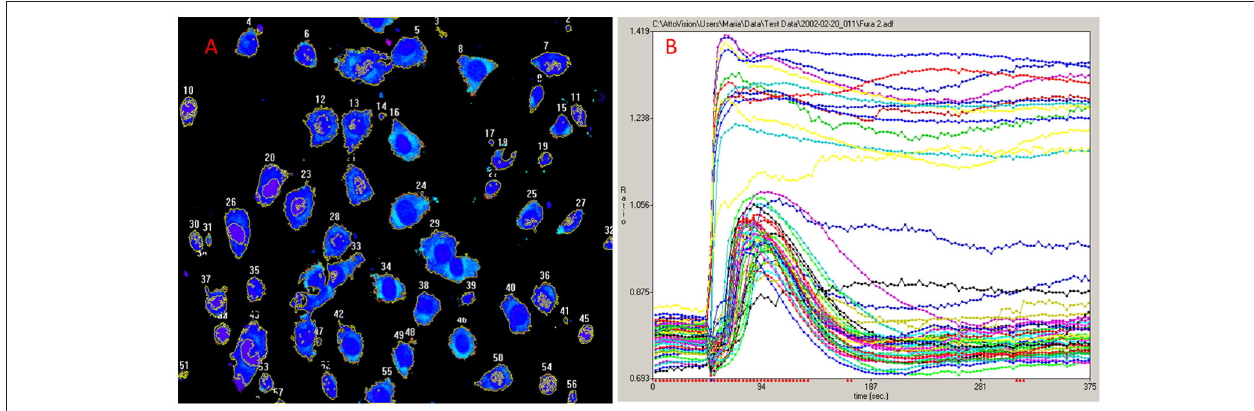
FIGURE 1 | Ca 2 + imaging. (A) NIH-3T3 cells ectopically expressing TRPV1 were loaded with the cytosolic Ca 2 + indicator Fluo-4-AM. (B) Minute scales imaging of [Ca 2 + ] i reveals two populations in NIH-3T3 TRPV1 cell line. A set of cells responds to 1 µ M CAP with non-declining increase of [Ca 2 + ] i and dies very soon while the other population survives the initial necrotic-phase in which the [Ca 2 + ] i transitions back to closed to its resting levels. This later option rarely occurs with RTX, as RTX is several thousandfold more potent than CAP in several assays (Szallasi and Blumberg, 1999). The original experiment was published in 2004 (Karai et al., 2004).